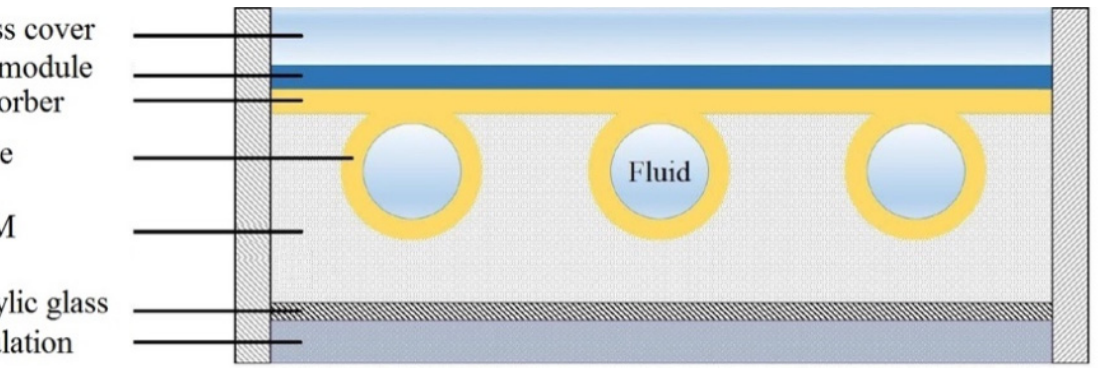
Figure 3. Diagram of an integrated PVT/PCM system [25].